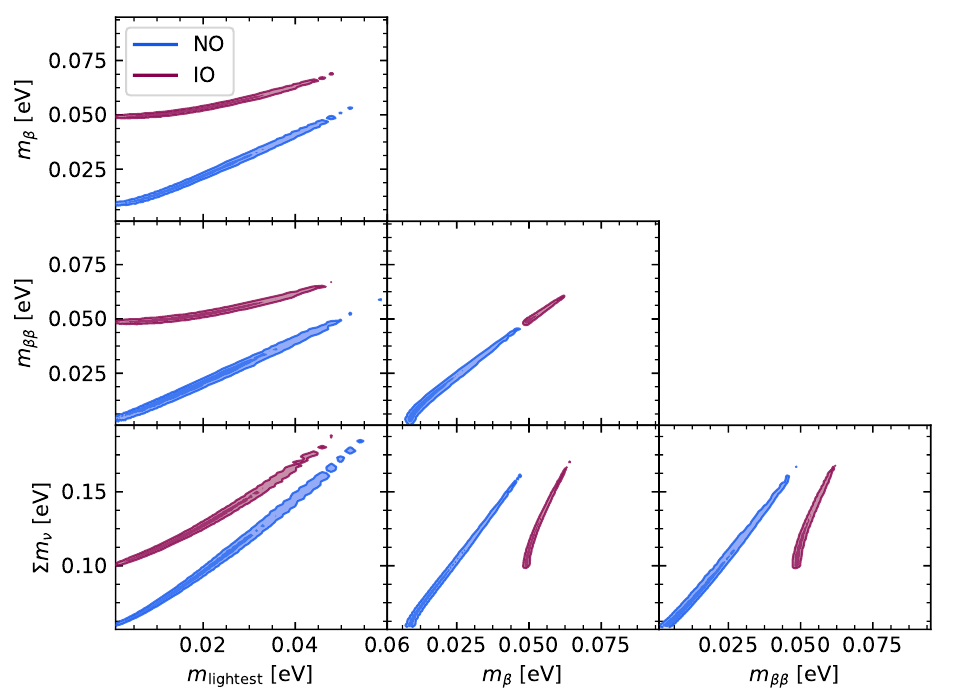
Figure 13 . Marginalized allowed regions at 1 σ (dark area) and 2 σ (light area) for m lightest , m β , m ββ and Σ m ν , obtained considering the data combination we denote as OSC+Cosmo, for NO (blue) and IO